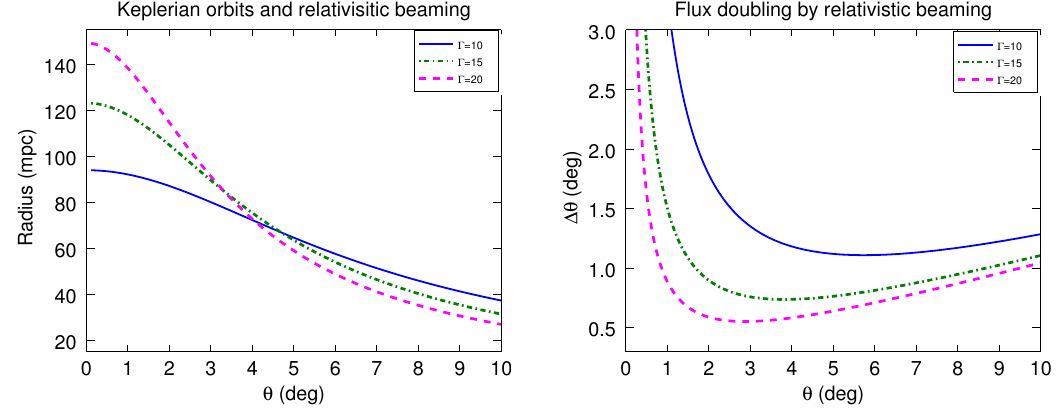
Figure 4. Left panel : Change in the radii (in milli-parsecs; mpc) of the Keplerian circular orbits around the black hole of mass of 10 9 M (cid:12) corresponding to the 563 d periodic signal carried by the emission regions traveling with the bulk Lorentz factors, Γ = 10,15, and 20, along the blazar jet viewed close to the line of sight. Right panel : The change in the viewing angle as a function of viewing angle for Γ = 10,15, and 20 required to double the apparent flux, keeping intrinsic flux constant, via relativistic beaming. A radio spectral index α = 0.6, typical of blazars, is used